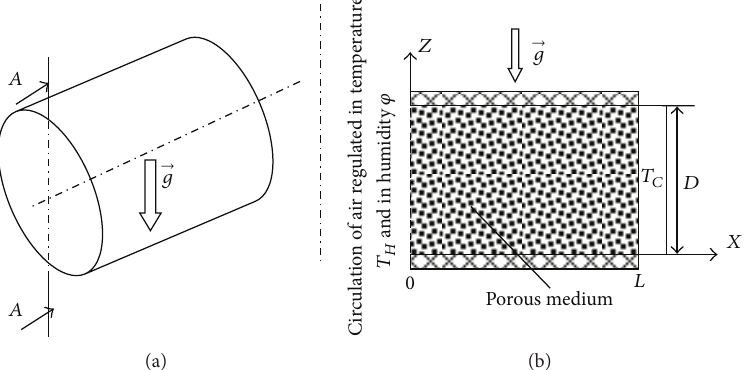
Figure 1: Physical model and coordinates system. (a) Physical model; (b) Section A - A showing the detail of the model used.